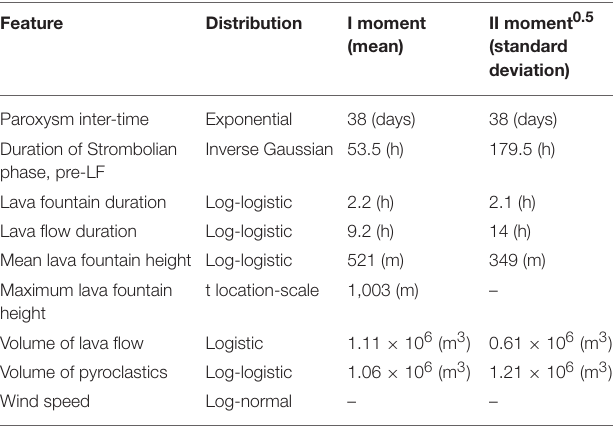
TABLE 3 | Distribution analysis of volcanological features for the set of paroxysms listed in Table 1 .